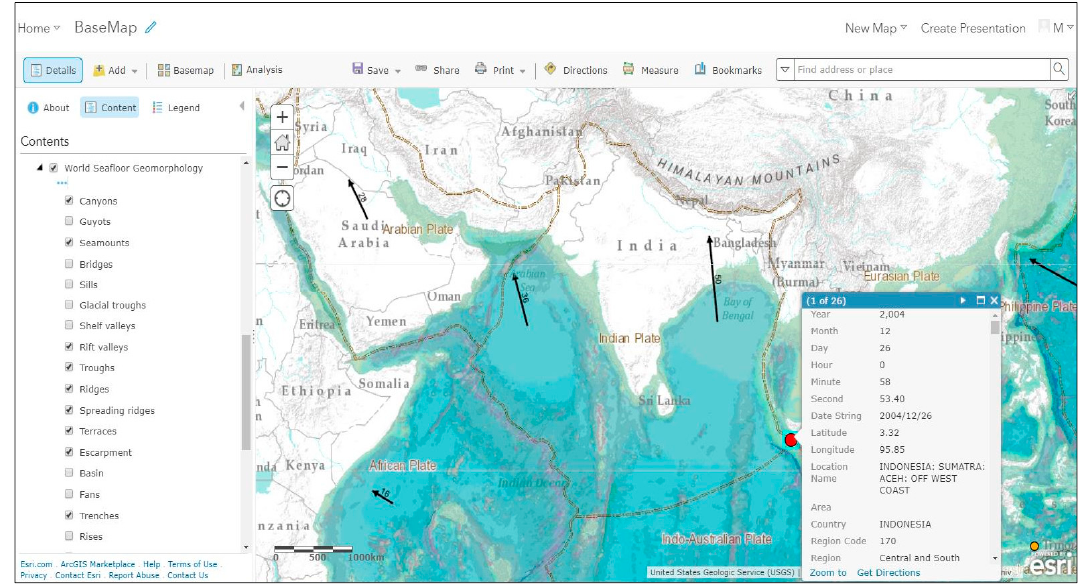
Figure 6. Exploring the causes of the 2004 Indian Ocean earthquake.